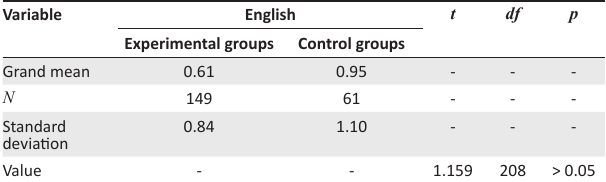
Standard deviation